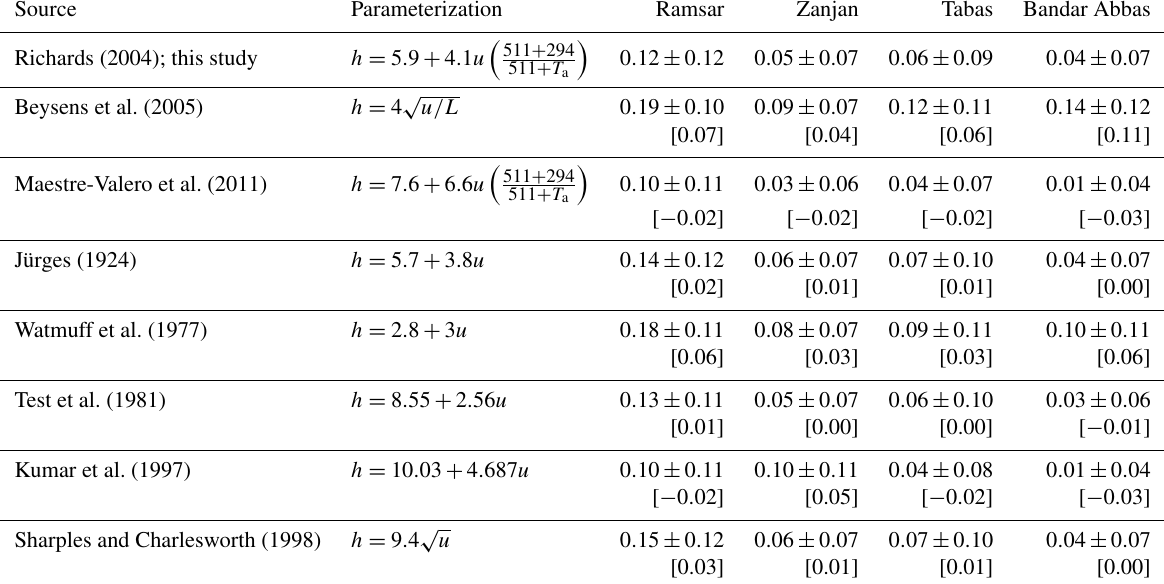
Table 6. A selection of eight parameterizations for the heat transfer coefficient, the mean ± std daily dew yield, and the mean differences between daily cumulative (Lm − 2 d − 1 ; negative values indicate the underestimated dew yield relative to the Richard’s parameterization and positive values indicate the overestimated dew yield) dew yield caused by each parameterization in four selected stations compared to the coefficient used in this study (i.e., Richards, 2004). The first three are studies on dew formation. Here, u and T a are the horizontal wind speed and air temperature at 2m height and L is the characteristic length of the condenser (e.g., 1m). Source Ramsar Zanjan Tabas Bandar